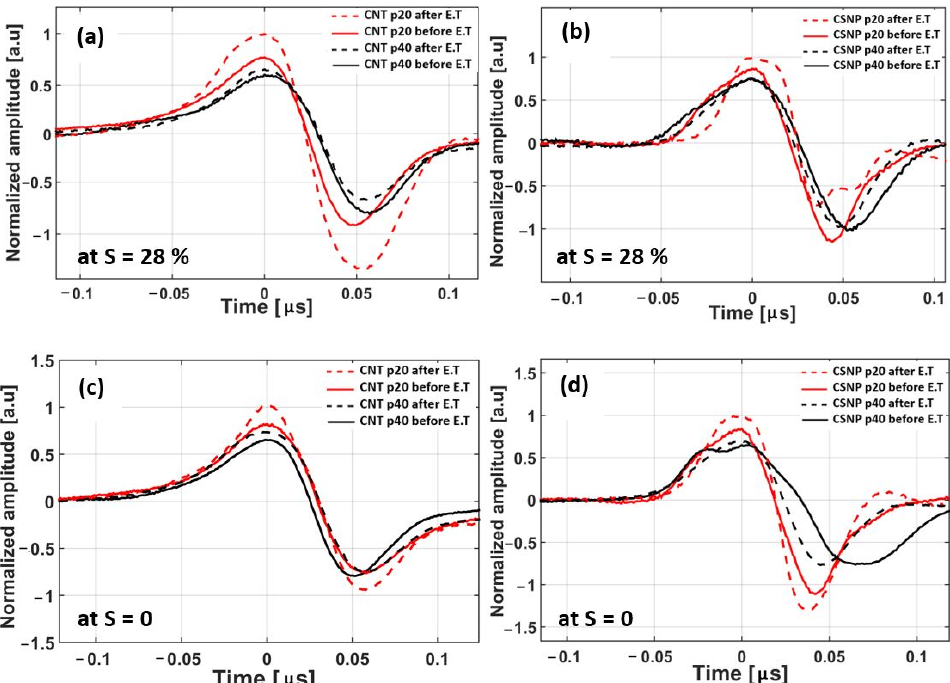
Figure 9. Comparison of time-domain PA waveforms before and after DET. ( a ) CNT-PDMS transmitters at S = 28%, ( b ) CSNP-PDMS transmitters at S = 28%, ( c ) CNT-PDMS transmitters at S = 0, and ( d ) CSNP-PDMS transmitters at S = 0. Note that the waveforms were measured first setting S =